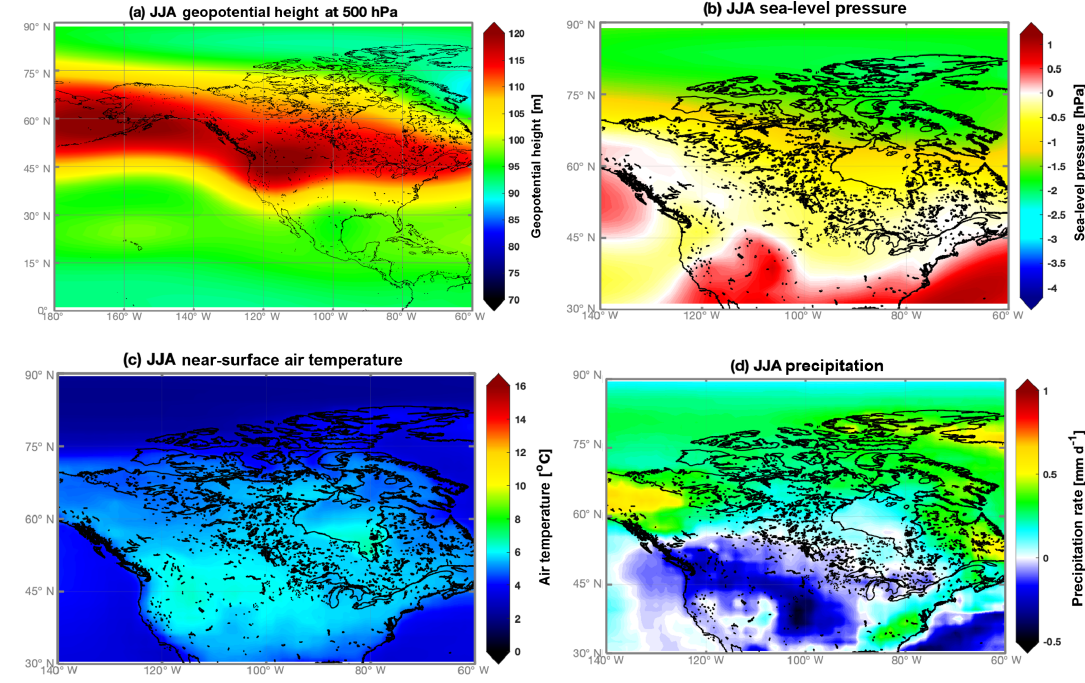
Figure 7. As in Fig. 2 but for summer (JJA).